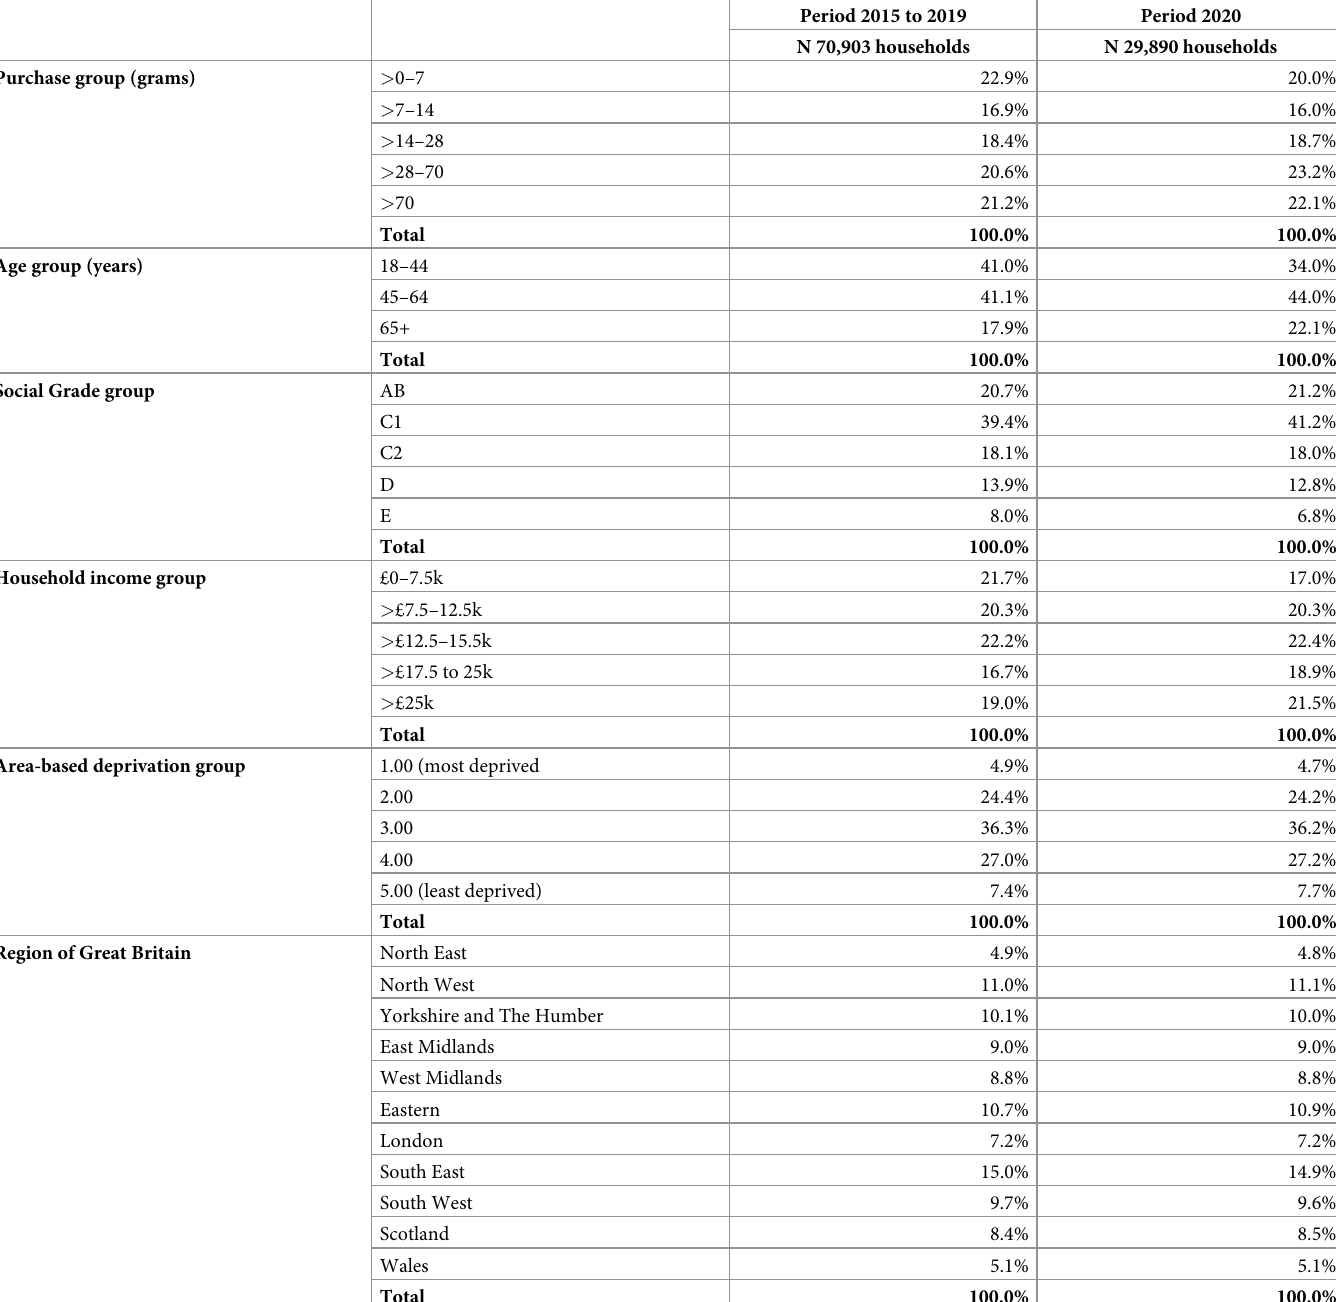
Table 2. Distributions of socio-demographic characteristics of households for the two time periods, 2015 to 2019 and